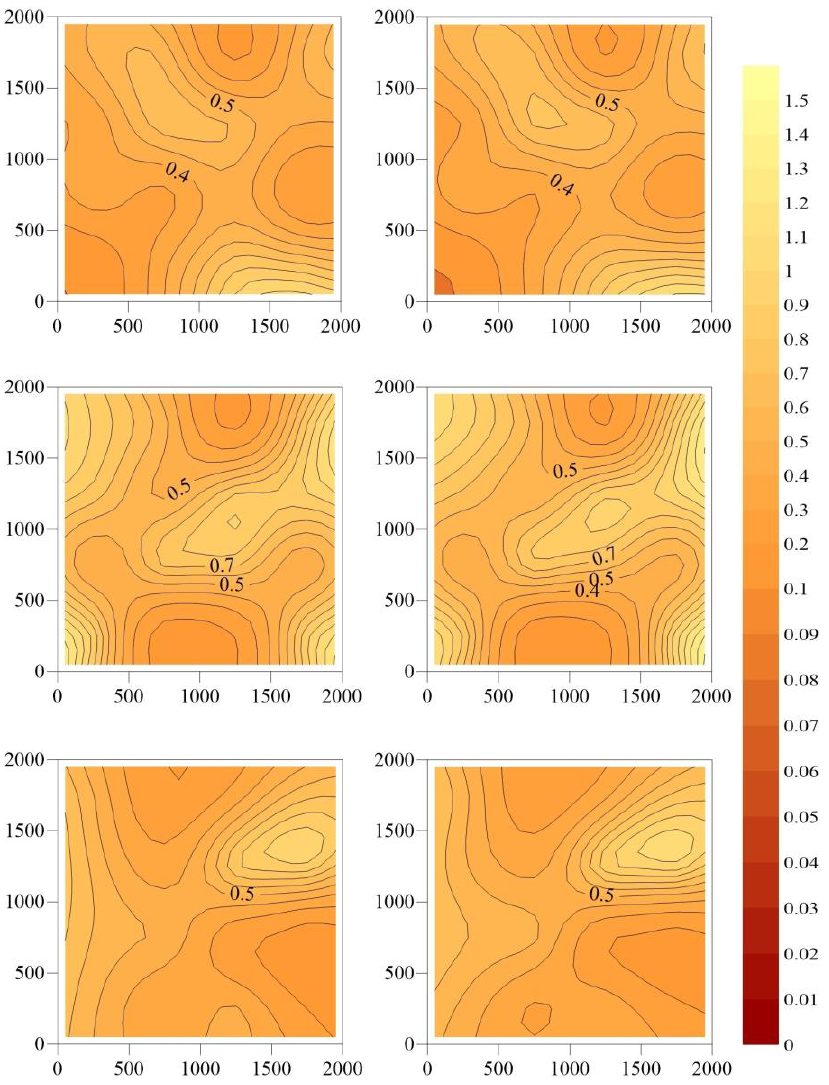
( ) | | 𝜀 ∈ 0.0075; 0.01 (on the right), per- 𝑖